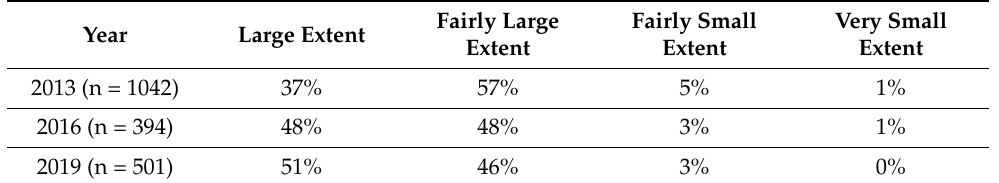
Table 5. Teacher responses to the statement ‘To what extent do you feel that the test results coincide with your own assessment of individual students’ competences?’ (2013, 2016 and